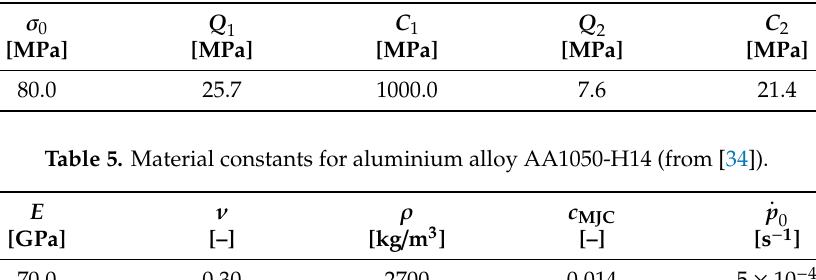
Table 4. Material hardening parameters for aluminium alloy AA1050-H14.